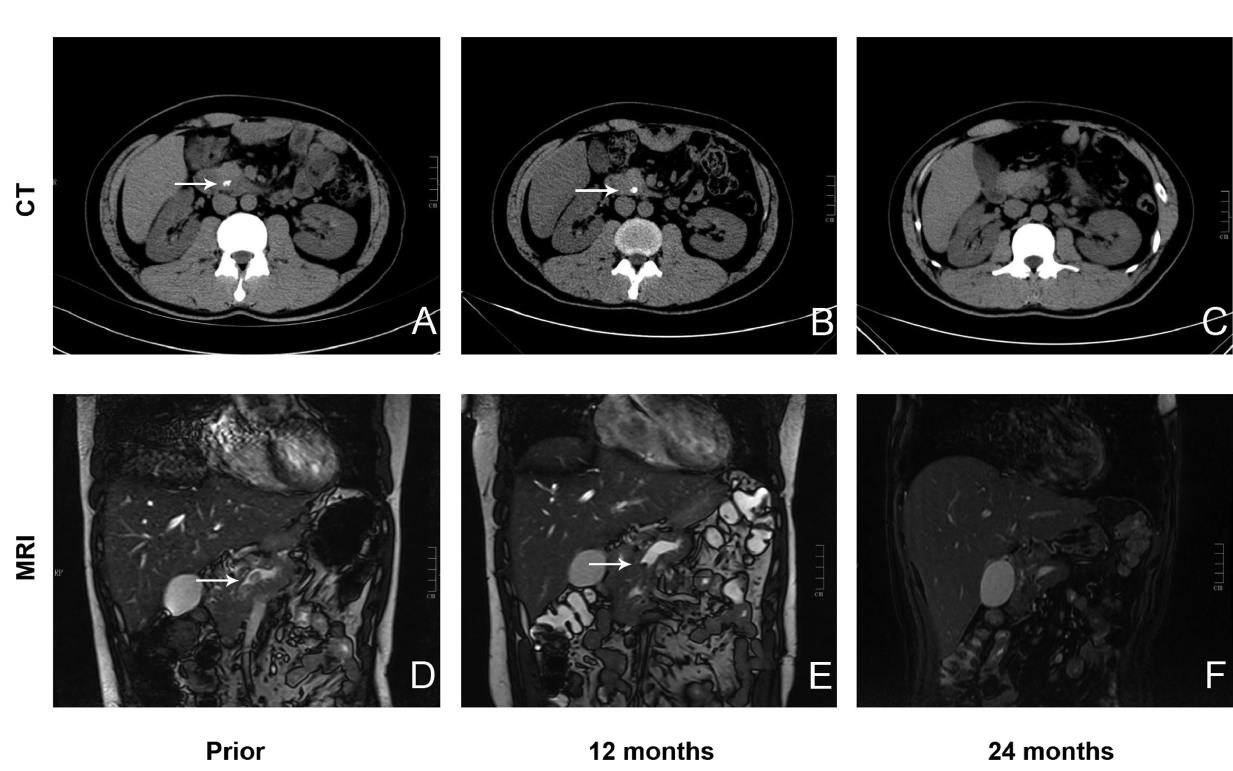
Figure 1. Dissolution of PDS with oral ECGG in a patient who had previously undergone ERCP and pancreatic sphincterotomy followed by balloon basket. (A) Cross-section CT image of the pancreas directly before treatment showing a relatively large stone in the head of the pancreas (arrows). (B) After oral ECGG treatment for 12 months, CT cross-section image showed a reduction in the size of PDS (arrows). (C) After oral ECGG for 24 months, CT cross-section image showed complete dissolution of PDS. (D) Magnetic resonance imaging coronal images of the pancreas directly before treatment showed a 0.9 cm diameter stone and many small stones in the pancreas head. (E) After oral ECGG treatment for 12 months, MRI coronal images showed a reduction in size and number of stones (arrows). (F) After oral ECGG treatment for 24 months, MRI coronal images showed complete dissolution of PDS. PDS, pancreatic duct stones; ECGG, endothelium corneum gigeriae galli; CT, computed tomography; MRI, magnetic resonance imaging; ERCP, endoscopic retrograde cholangiopancreatography. Table 2. Effect of ECGG Treatment on Dissolution of PDS